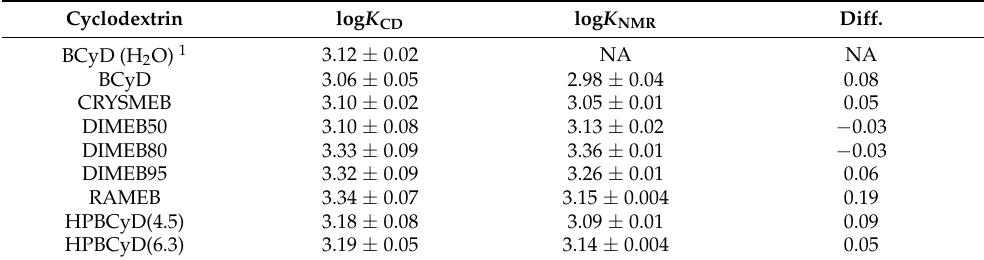
Table 4. The complex stability constants (in log10 units ± standard error) of fenoprofen with the various cyclodextrins determined by CD and 1 H NMR spectroscopy in 90% H 2 O/10% methanol- d 4 .